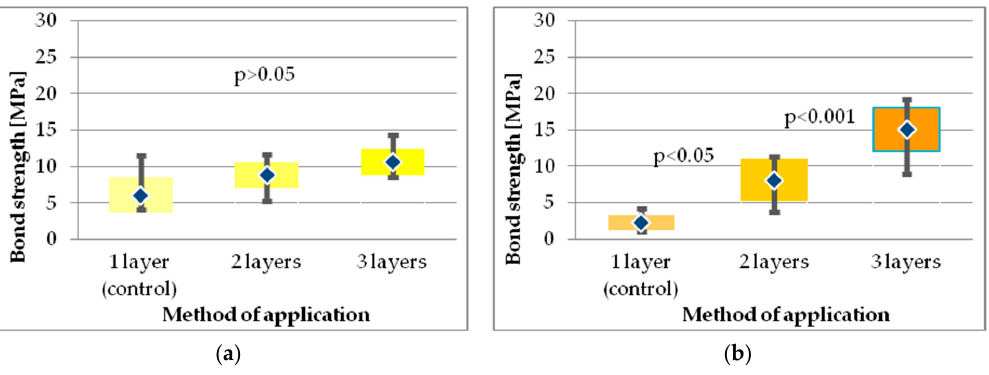
Figure 10. SBS results of self-etch adhesives: ( a ) Adper Easy One; ( b ) Xeno V.